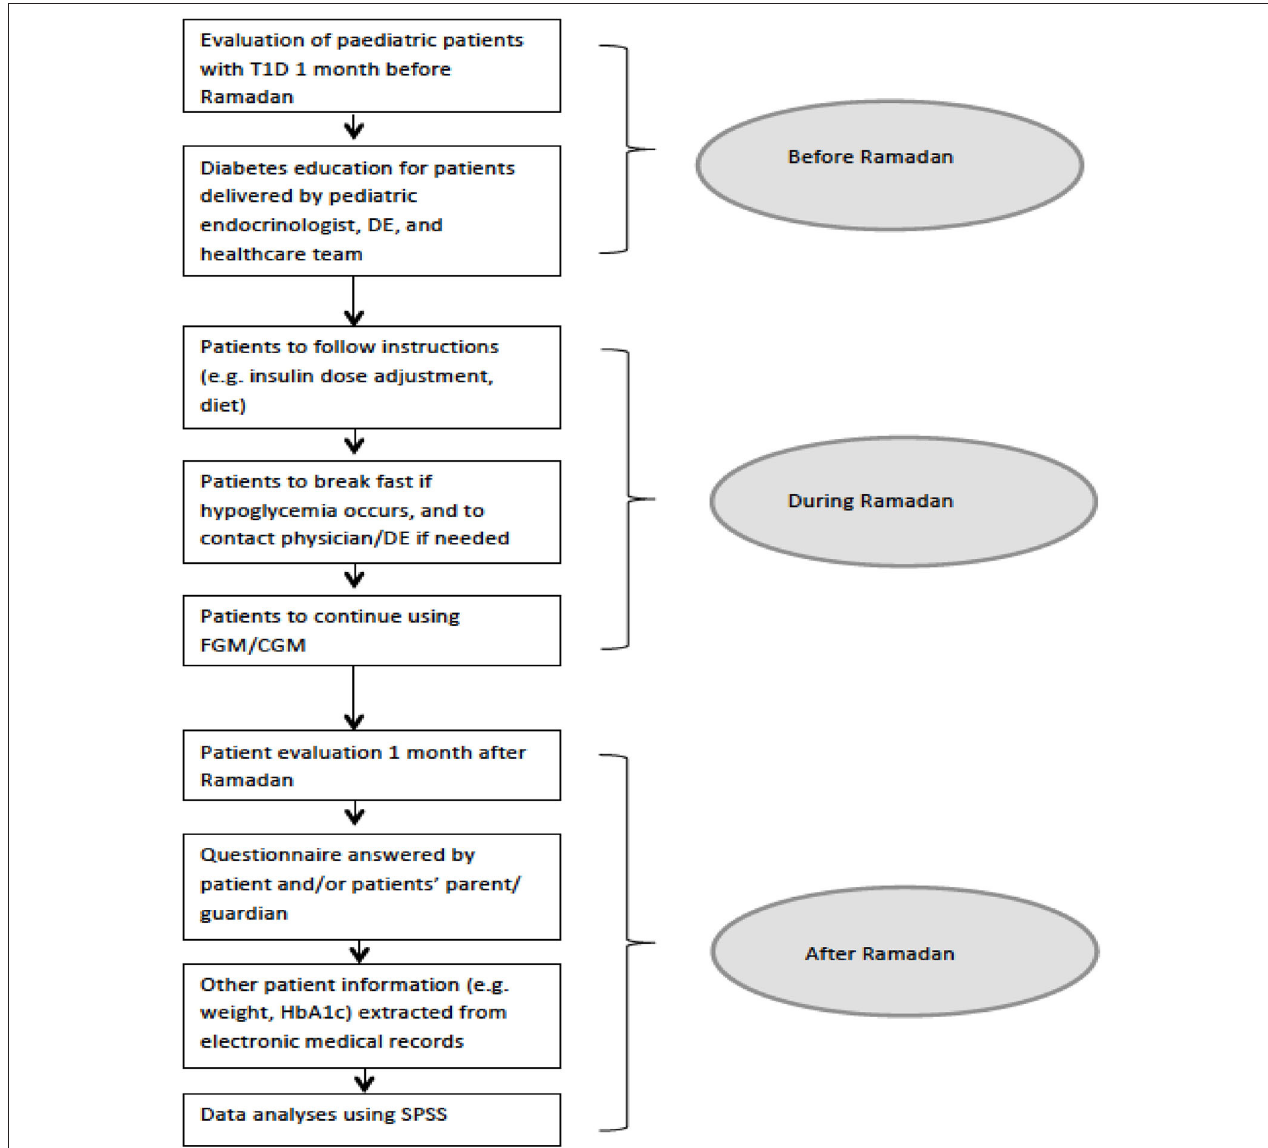
FIGURE 1 | Study flowchart: an overview of study design. T1DM, type 1 diabetes mellitus; DE, diabetes mellitus educator; CGM, continuous glucose monitoring; FGM, flash glucose monitoring; SPSS, Statistical Package for the Social